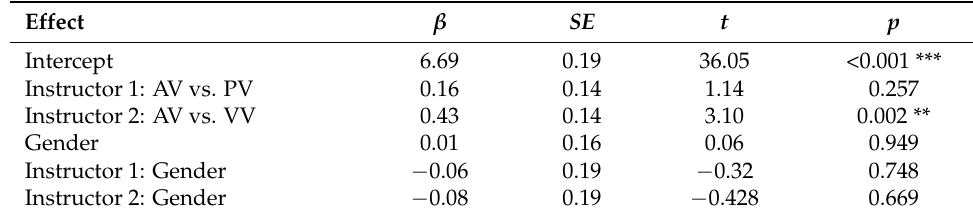
Table 2. Results of linear mixed-effects models for comprehension scores.